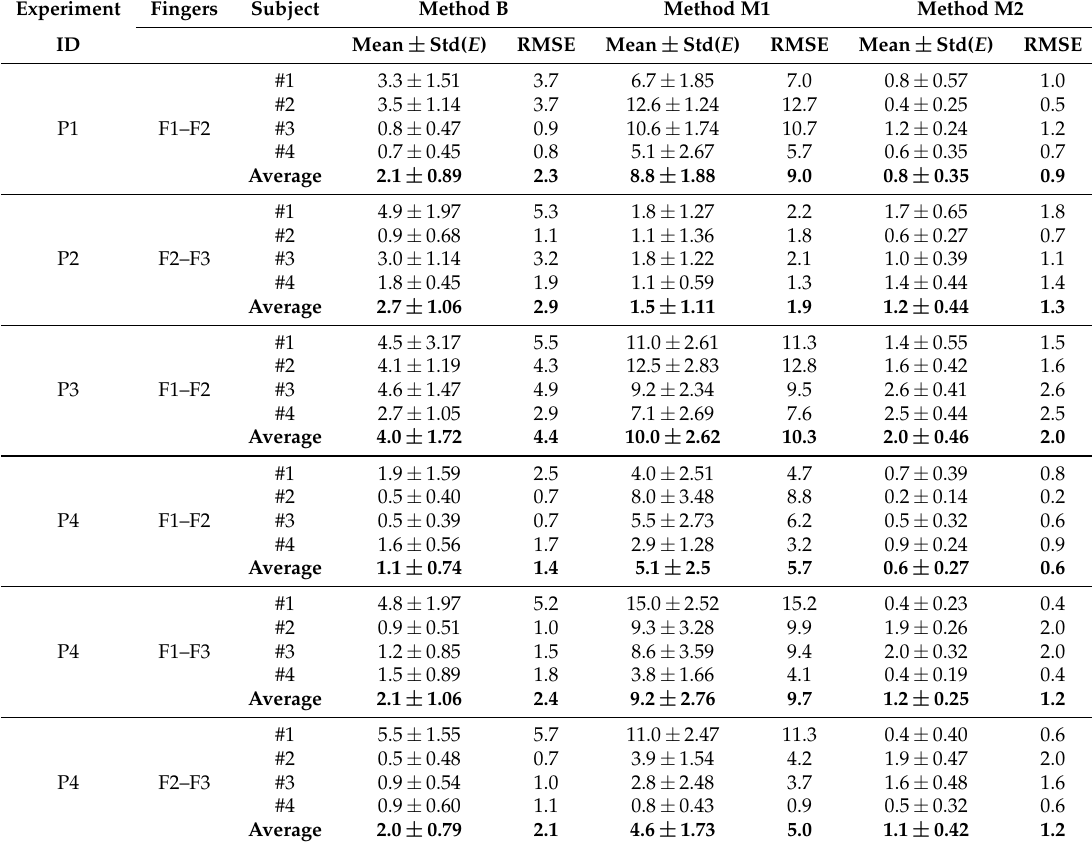
Table 7. Mean and standard deviation (std) of error E [cm] and RMSE [cm] for experiments P1–P4 in the realistic environment of Setting 2. Average and individual results of each participant are included.